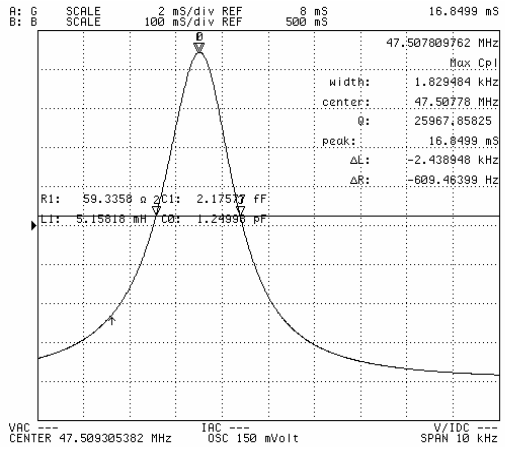
Figure 7. Measured conductance characteristics of a 47 MHz QCM chip in the custom-designed flow cell.